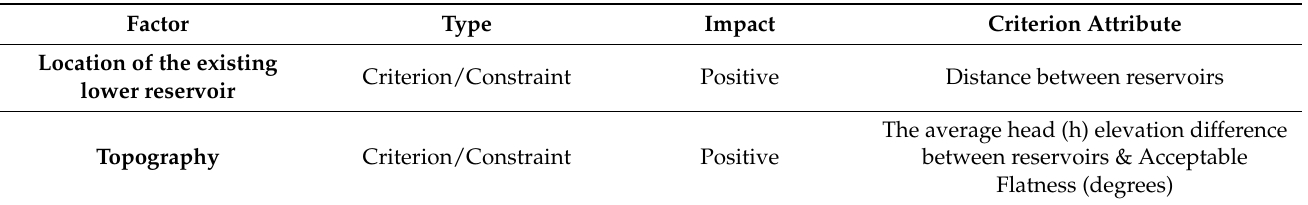
Table 2. Design criteria and